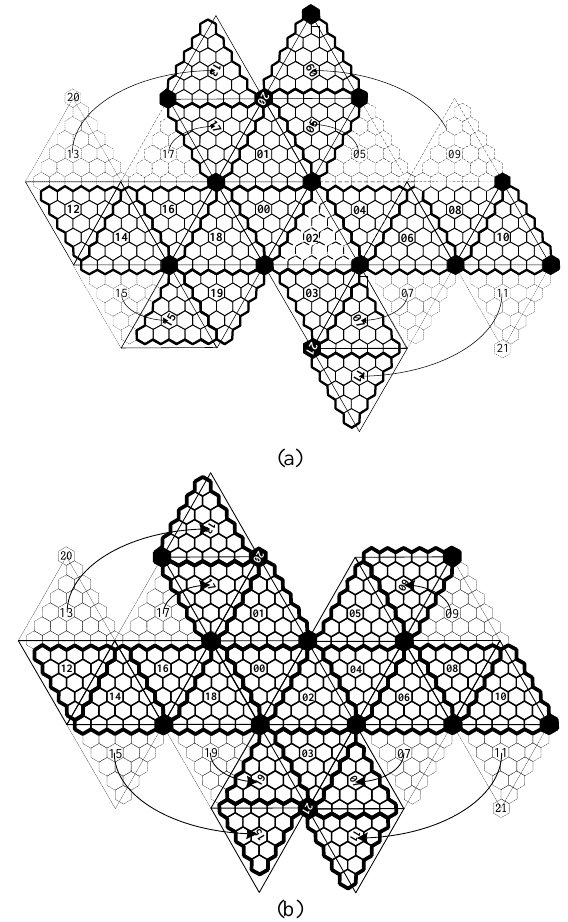
Figure 2. Case of unfolded icosahedron, up and down triangle facets was taken as the center. (a) Down triangle facet 00 was taken as the center, icosahedron was unfolded; (b) Up triangle facet 02 was taken as the center, icosahedron was